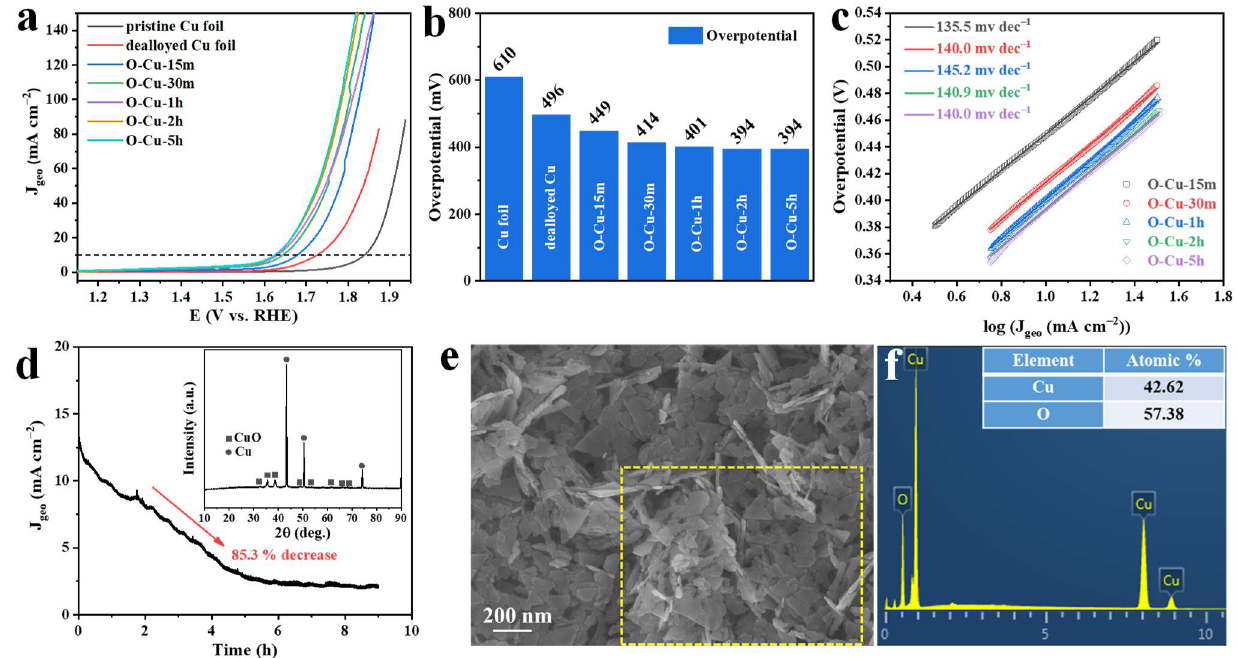
Figure 7. The OER performance of the oxidized samples. ( a ) LSV curves of pristine Cu foil, dealloyed Cu foil, O-Cu-15m, O-Cu-30m, O-Cu-1h, O-Cu-2h, and O-Cu-5h. ( b ) Overpotential obtained at 10 mA cm − 2 current density. ( c ) Tafel slopes of the five oxidized samples. ( d ) i-t curves of O-Cu-2h at 1.65 V vs. RHE. ( e ) SEM image and ( f ) EDX spectrum of O-Cu-2h after stability test. The inset of Figure 6d is the XRD pattern of O-Cu-2h after the stability test.